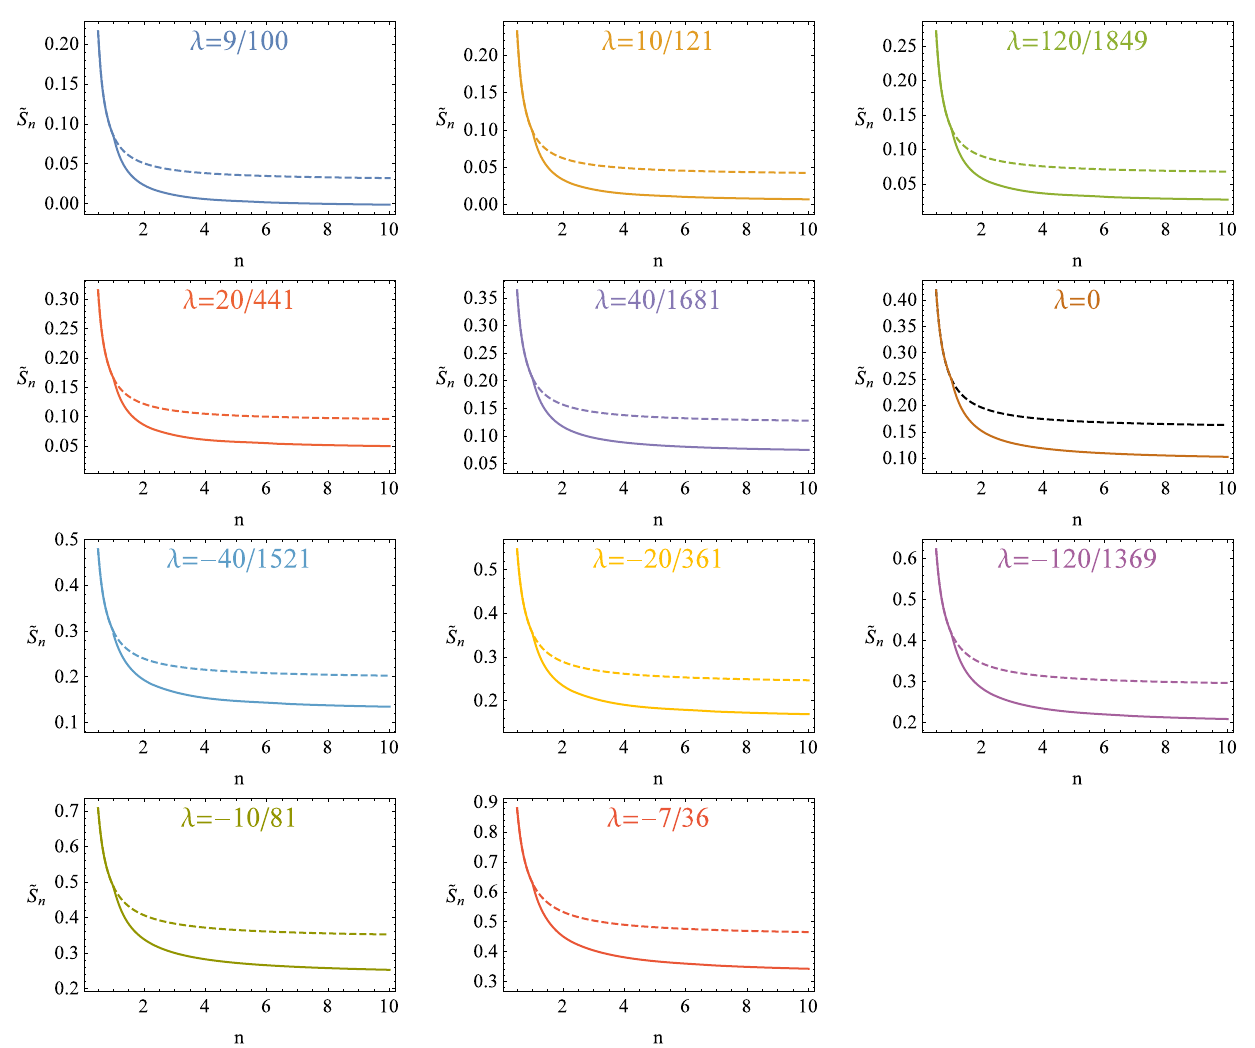
Fig. 9 In each diagram there is a critical point where the ERE of the modified hairy black hole (solid curve) approaches that of the EGB black hole (dashed curve)